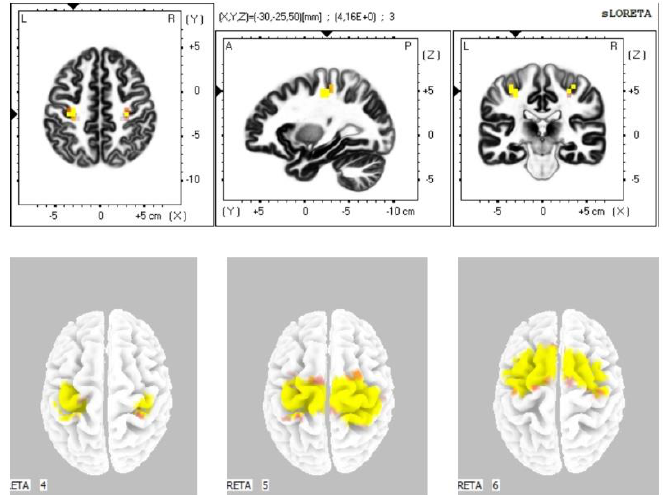
Figure 2. Statistically significant source activity in sLORETA imaging at the significance level p ≤ 0.05 for the alpha-1 band ( top image ), alpha-2 band ( bottom-left image ), beta-1 band ( bottom-middle image ), and beta-2 band ( bottom-right image ). Yellow and orange voxels indicate areas with increased electrical brain activity.